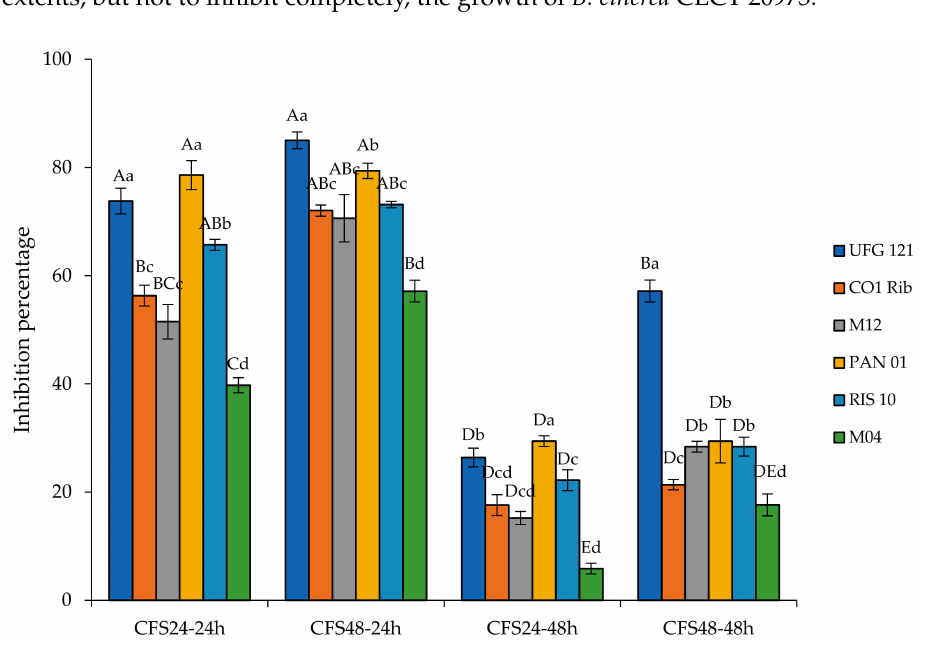
Figure 2. Hyphal radial growth inhibition of B. cinerea after 24 h and 48 h of incubation at 25 ◦ C on plates of malt extract agar supplemented with 20% of CFS24 and CFS48 of the selected LAB strains. Capital letters indicate significant differences among the inhibition percentage of CFSs at all the experimental conditions. Lowercase letters indicate significant differences among the inhibition percentage of CFSs inside each experimental